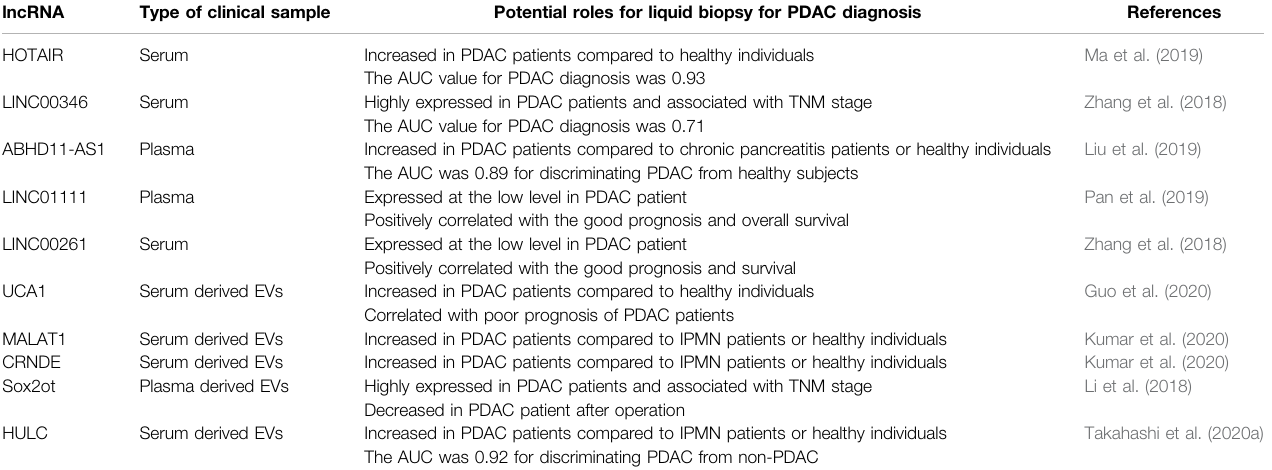
TABLE 2 | LncRNAs as tools of liquid biopsy for